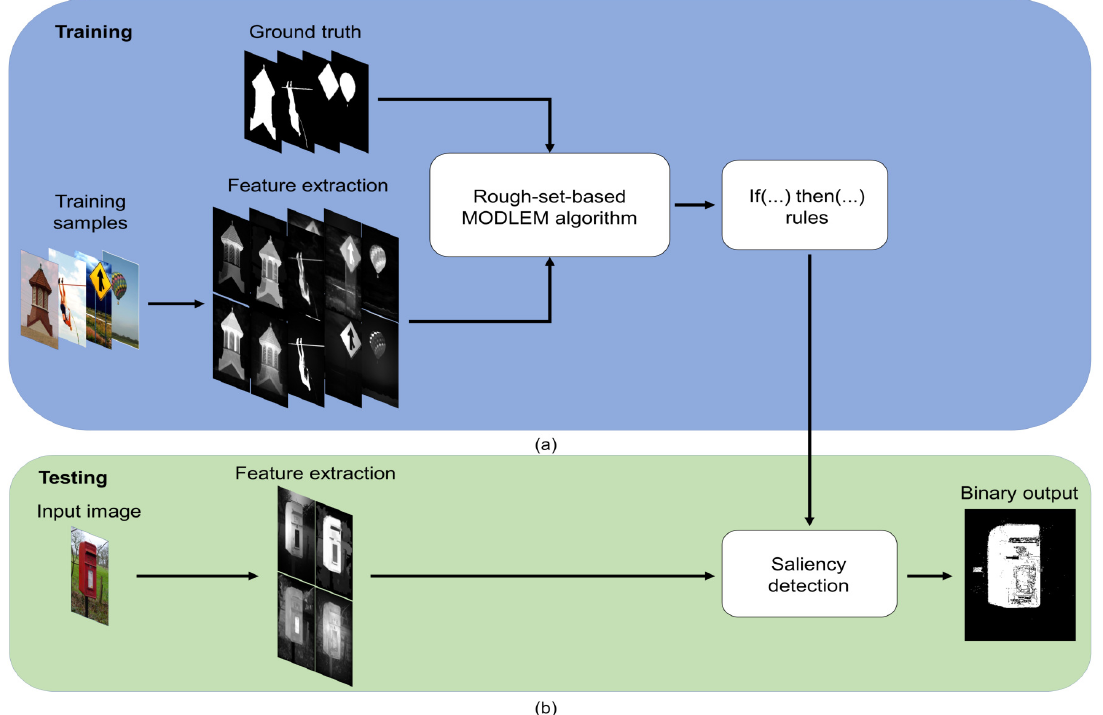
Figure 1. Overview of our proposed model. ( a ) Feature extraction is performed. Then, a learning process is carried out by using the MODLEM algorithm. ( b ) Using the obtained model, a saliency prediction is performed and the output is given in a binary